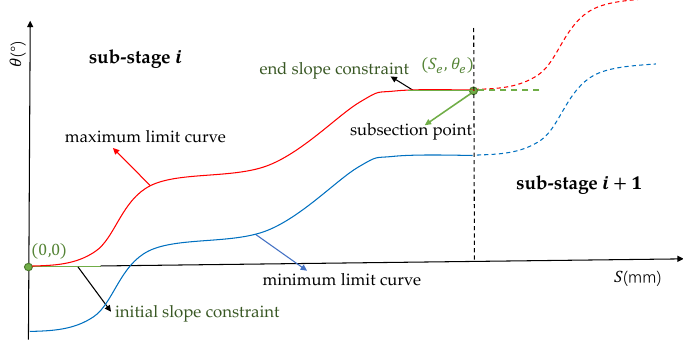
Figure 6. Decoupling in the S - θ plane.